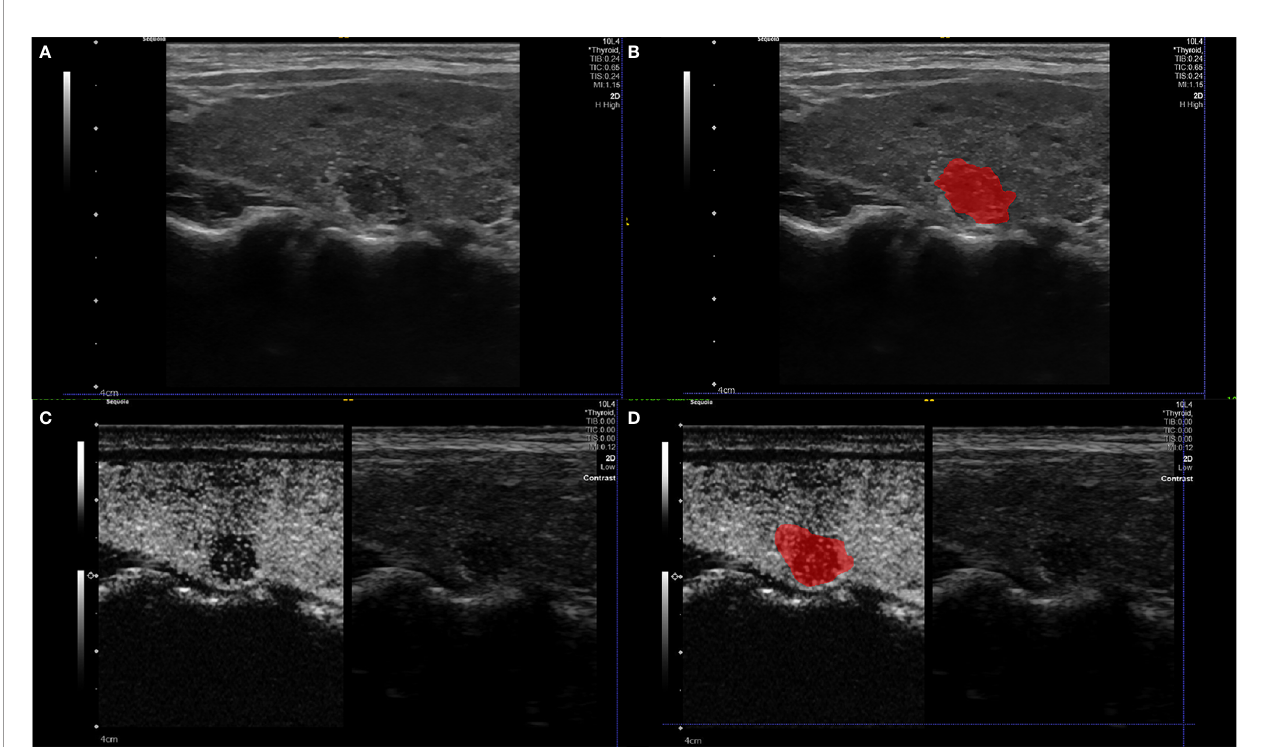
FIGURE 3 | Example (A, B) of delineating region of interest (ROI) on a B-US image, we detailed the outline along the nodule boundary on the largest long-axis cross-section of the nodule. Example (C, D) of delineating region of interest (ROI) on a CEUS image. The ROI includes the target node and some of its adjacent tissues (22).